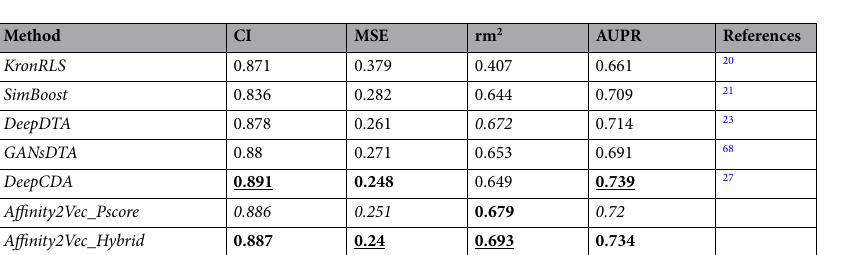
Table 4. Comparing Affinity2Vec with five baseline methods in terms of CI, MSE, rm2, and AUPR scores for the Davis dataset on the test data. Bold font with underline indicates the best results, bold font alone shows the second-best results, and italic font shows the third-best results.